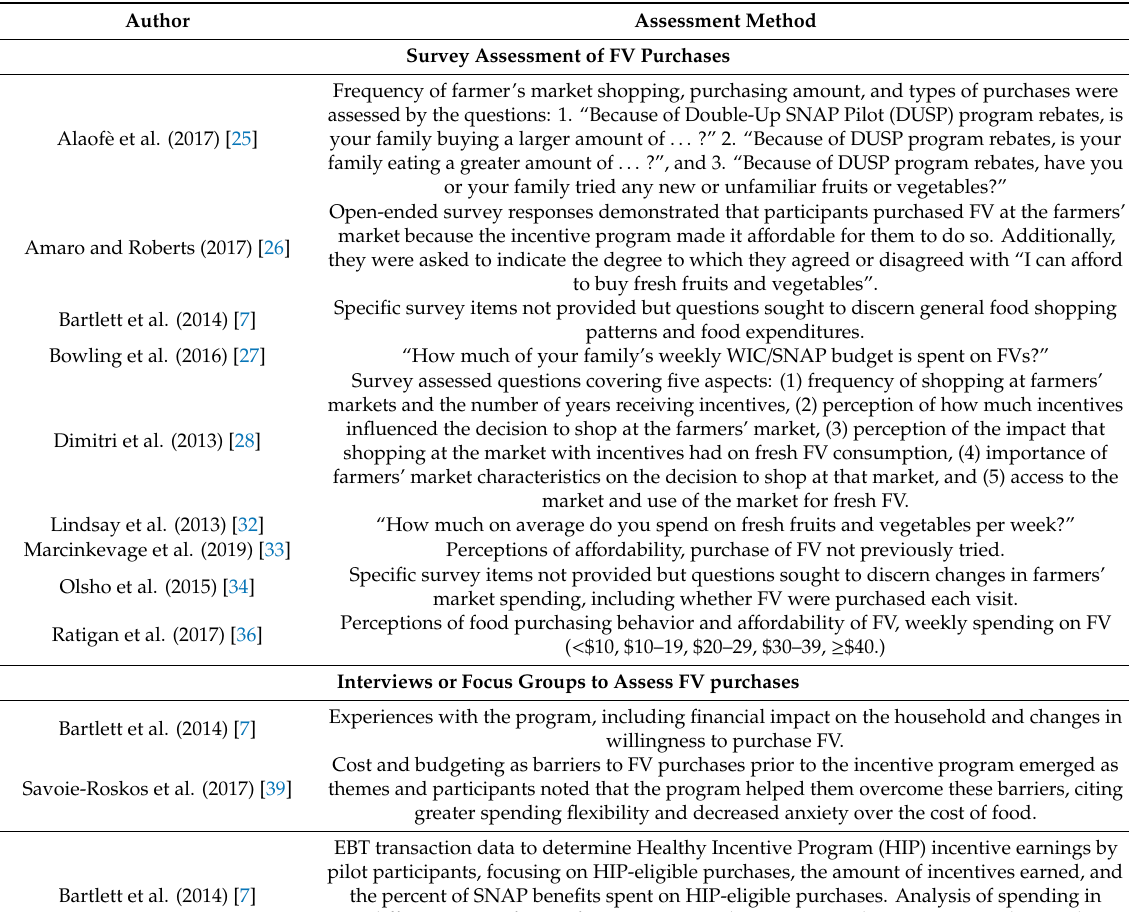
Table 2. Assessment of fruit and vegetable purchases in nutrition incentive